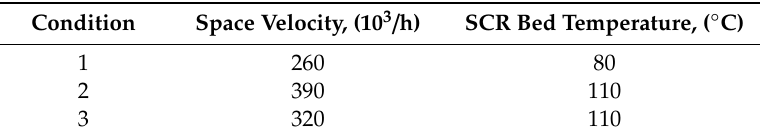
Table 4. Conditions